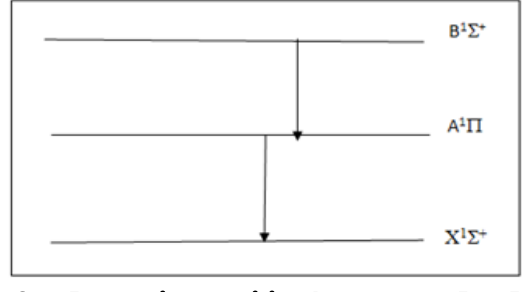
Fig.4: Diagram for electronic transition between molecular energy levels. Table 5: Values of wave numbers for P,Q and R branch for A 1 Π-X 1 Σ +